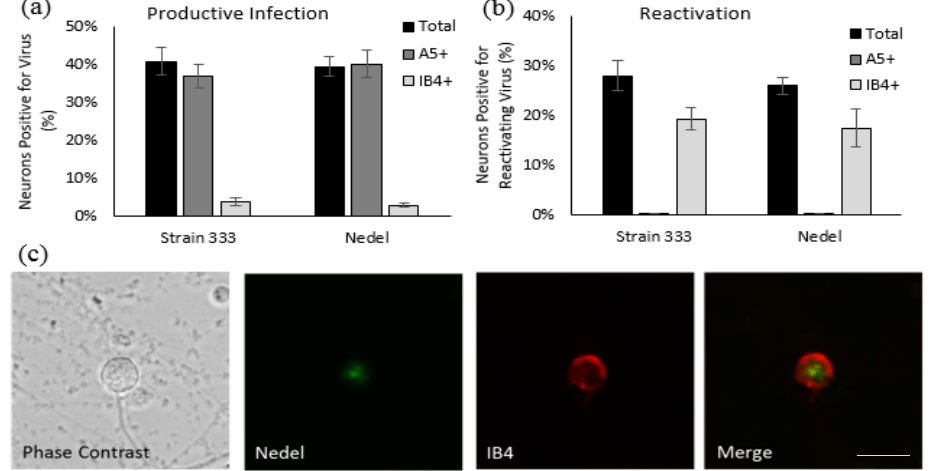
Figure 3. Nedel-infected cultured primary adult murine sensory neurons. ( a ) Productively infected neurons, quantified by counting total and immunolabeled A5+ and IB4+ subpopulations of neurons that contained mNeonGreen, expressed as a percentage of neurons counted. ( b ) Reactivating neurons, expressed as a percentage of total neurons reactivating and a percentage of total reactivations that occurred in A5+ and IB4+ neurons. ( c ) Representative image of Nedel reactivating in an IB4-labeled neuron, showing that Nedel reactivates in IB4+ sensory dorsal root ganglia neurons, as described previously for wild-type Strain 333 [16]; yellow bar = 15 µm.